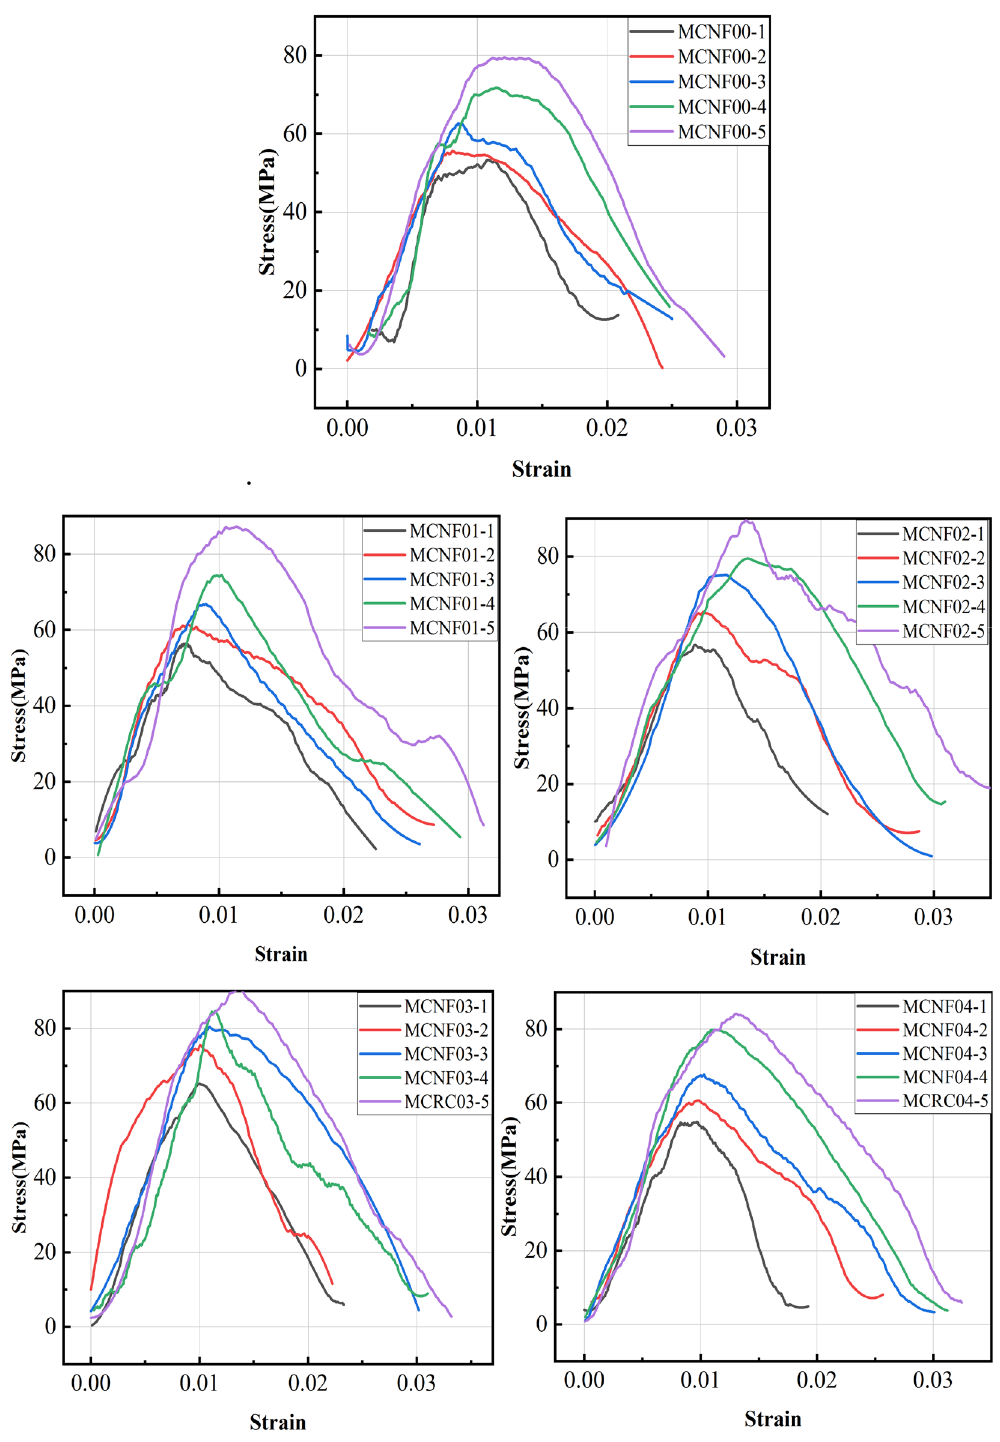
Figure 6. The stress–strain curves of MCNF